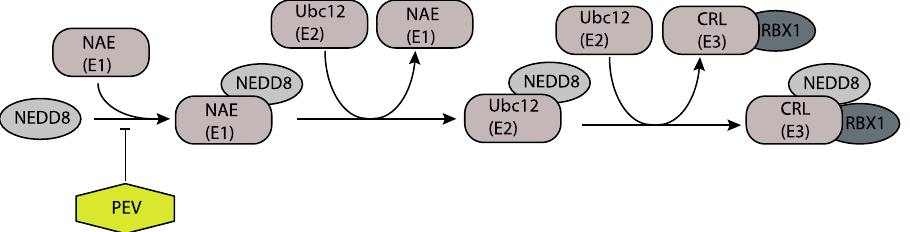
Figure 6. Neddylation pathway and its inhibitor pevonedistat. The activation of the largest ubiquitin ligases subgroup cullin-ring ligases (CRLs) starts with activation of NEDD8 by the NEDD8 E1 activation enzyme (NAE) in an ATP-dependent reaction. Afterwards, it transfers to the conjugation enzyme E2. The NEDD8 charged E2 then conjugates NEDD8 to a cullin-containing RING finger ligase (CRL). The neddylation pathway can be disrupted by the small molecule inhibitor pevonedistat, which inhibits